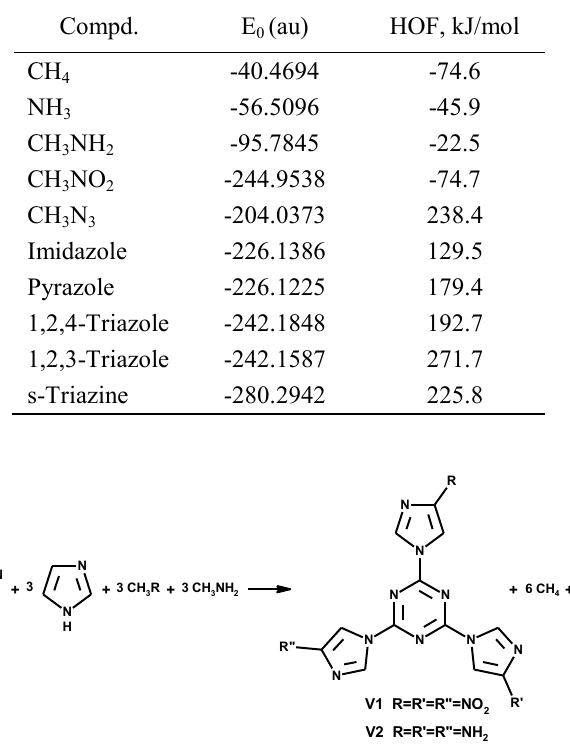
Table 1. Total energy (E ) at the B3LYP/6-31 G * level and experimental HOFs for the 0 reference